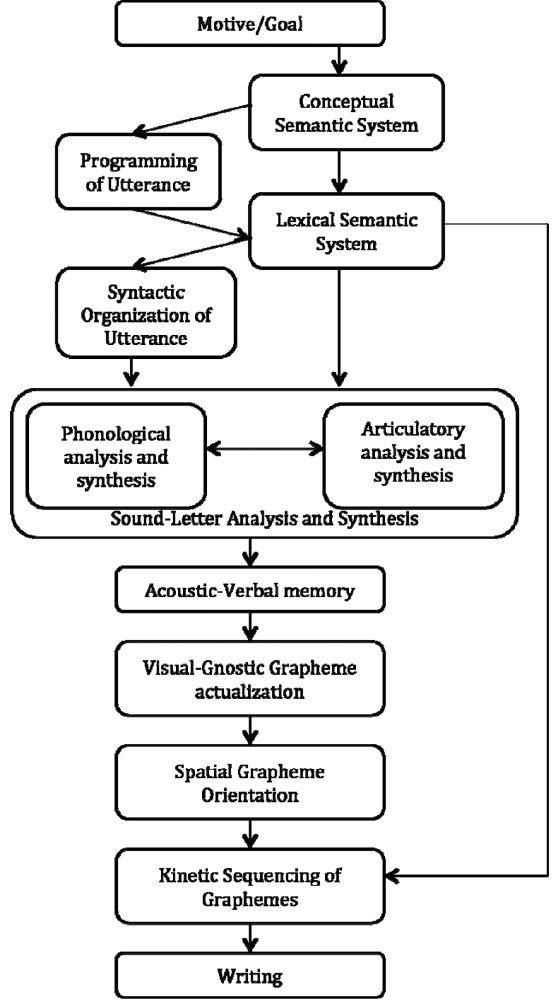
Fig. 1. Cognitive structure of spontaneous writing and written nam- ing in Luria’s approach. The following connections were omitted for better visual represen- tation: each one of the elements { writing, sound-letter analysis and synthesis, syntactic organization of utterance, lexical seman- tic system } is connected to { motive/goal and conceptual seman- tic system } ; each one of the components { kinetic sequencing of graphemes, spatial grapheme orientation, visual-gnostic grapheme actualization, acoustic verbal memory } is connected to { conceptual semantic system and motive/goal }